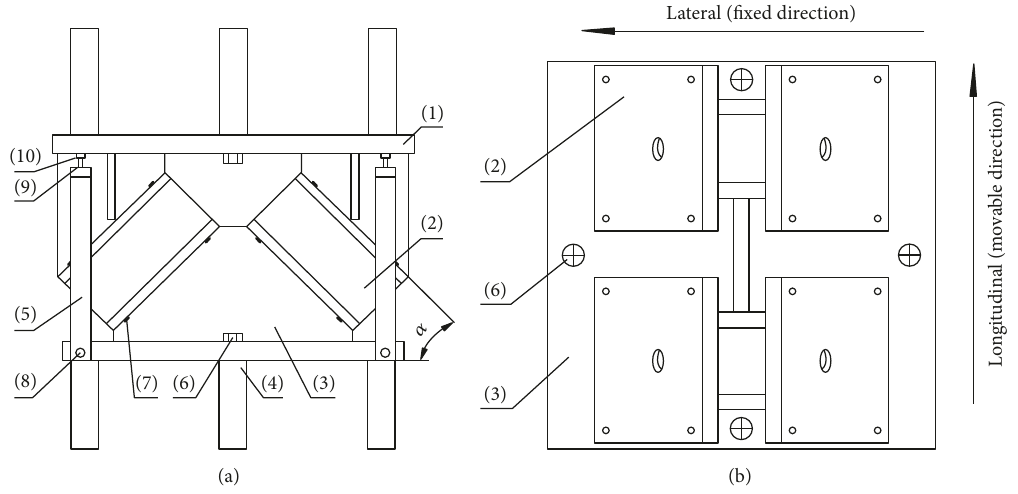
Figure 3: The structure diagram of novel antivibration bearing: (a) front view and (b) relative location arrangement diagram of rubber blocks. Notes . (1) Upper plate; (2) high-damping thick rubber block; (3) lower plate; (4) anchor stud; (5) connection plate; ( 6 ) ∼ ( 9 ) bolt; (10)